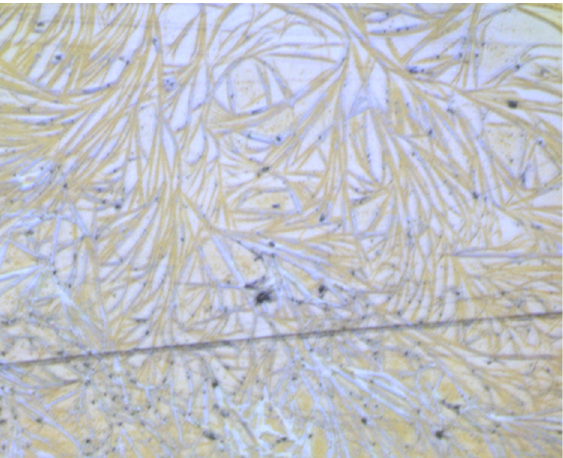
Figure 8. Microscopic image of a precipitate from “stored” LAE solution. Image size 500 × 400 µm.